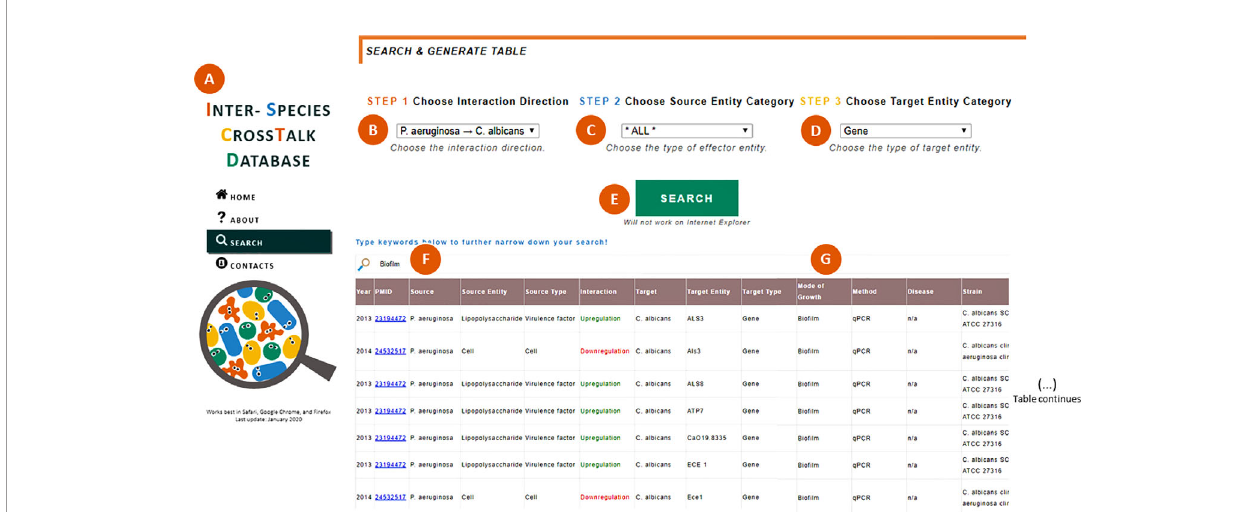
FIGURE 2 | Searching within the ISCTD. (A) Navigation panel that allows users to jump within the webpage, including to the “ Search ” section. (B) Selection of the interaction direction of interest, here exempli fi ed by the effect of P. aeruginosa on C. albicans . (C) Selection of the source entity category, which can be left unspeci fi ed by selecting the option “ All ” . (D) Selection of the target entity category, here exempli fi ed by “ gene ” . (E) When clicking the “ Search ” button, a table is generated containing all the information annotated by the expert curators and sifted through the user ’ s selection in (B – D) . (F) Users can type keywords to further specify their search, here exempli fi ed by “ bio fi lm ” . (G) Table is narrowed down to show only interactions observed in bio fi